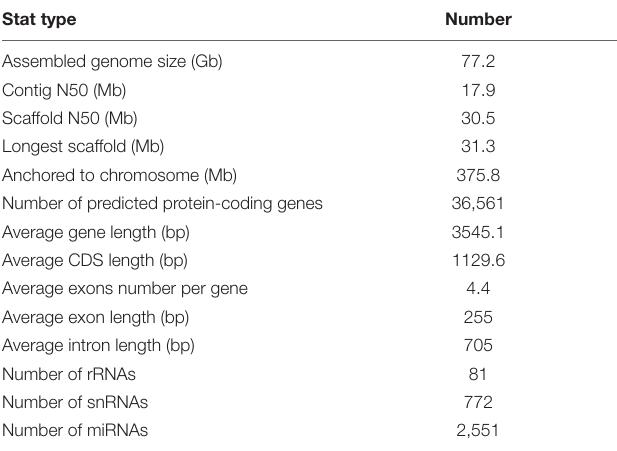
TABLE 1 | Summary of the sequencing, assembly, and annotation of the LM8 genome.